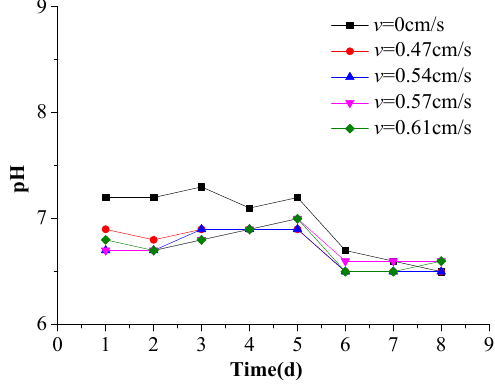
Figure 5. Variations in the pH of the overlying water during the experiment.